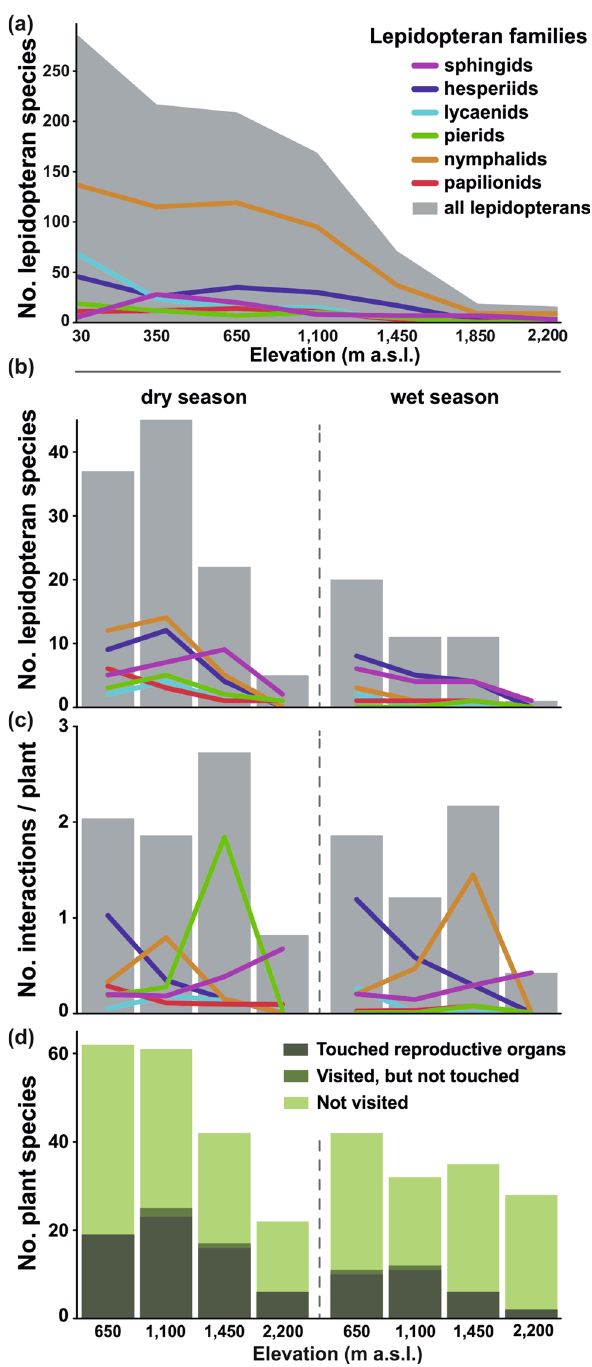
Figure 1. Overview of ( a ) lepidopteran species richness along the elevational gradient of Mount Cameroon, ( b ) total number of flower-visiting lepidopteran species at each elevation and season, ( c ) interaction frequency per plant and 24hrs, and ( d ) numbers of plant species whose reproductive organs were touched or untouched during lepidopteran visits, and which were not visited by any lepidopterans. Grey shading in ( a )–( c ) denotes the sum of all lepidopteran taxa; coloured lines represent particular